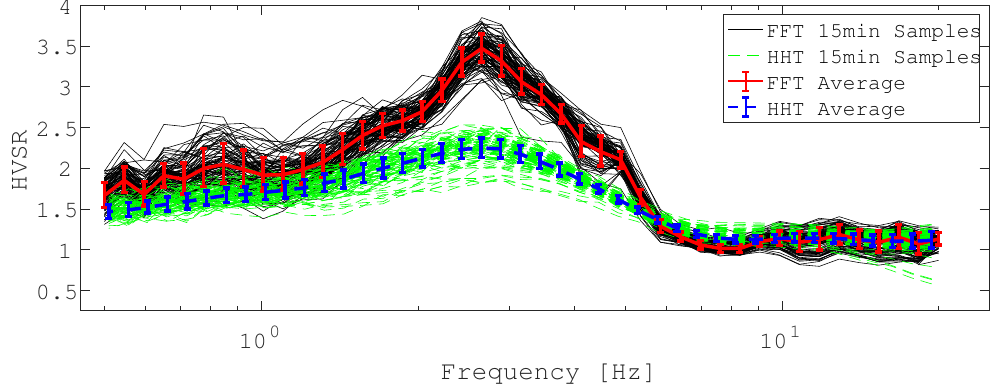
Figure 2. ICJA results for FFT- and MEMD-based